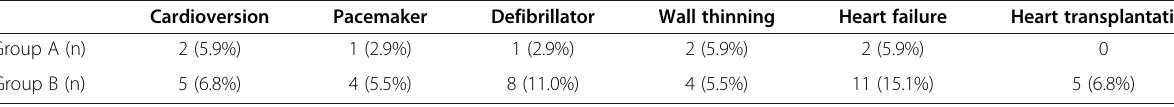
Table 5 complications in group A and B